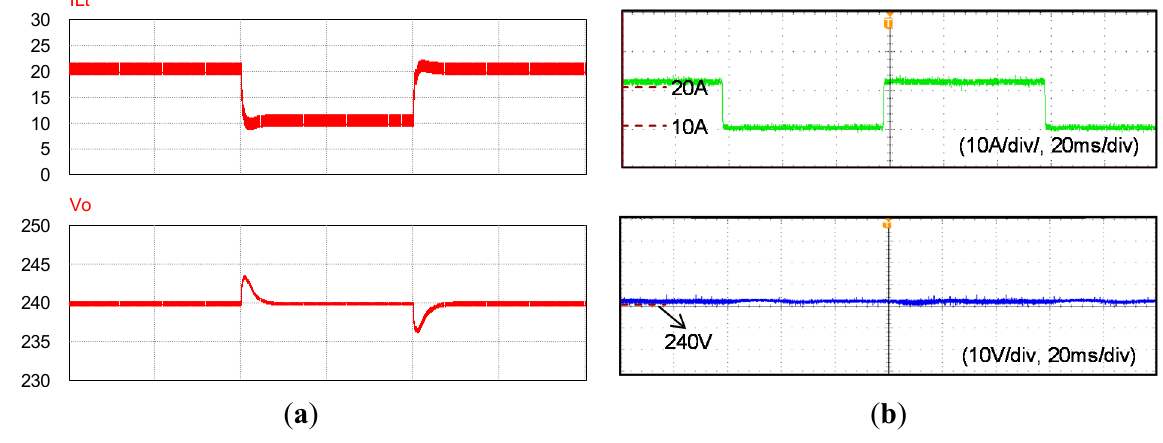
Figure 22. Waveforms of transient response for load period steps in discharge mode from 500 W to 250 W and then back to 500 W: ( a ) by simulation; and ( b ) by